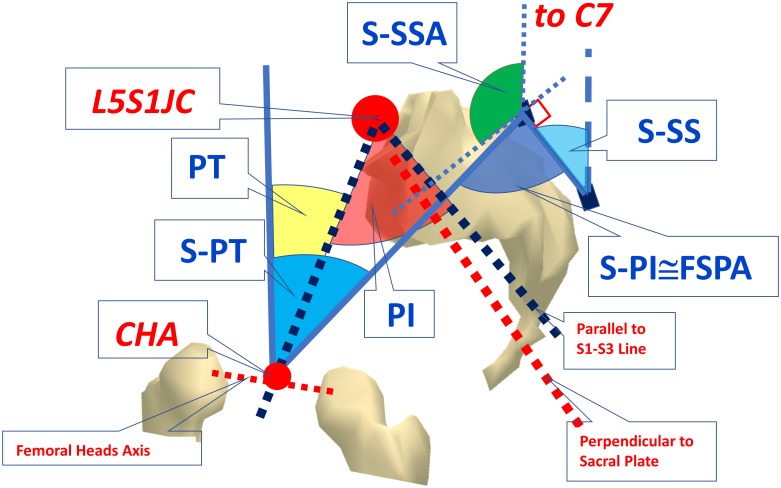
Pelvic parameters.See definitions in Table 2.